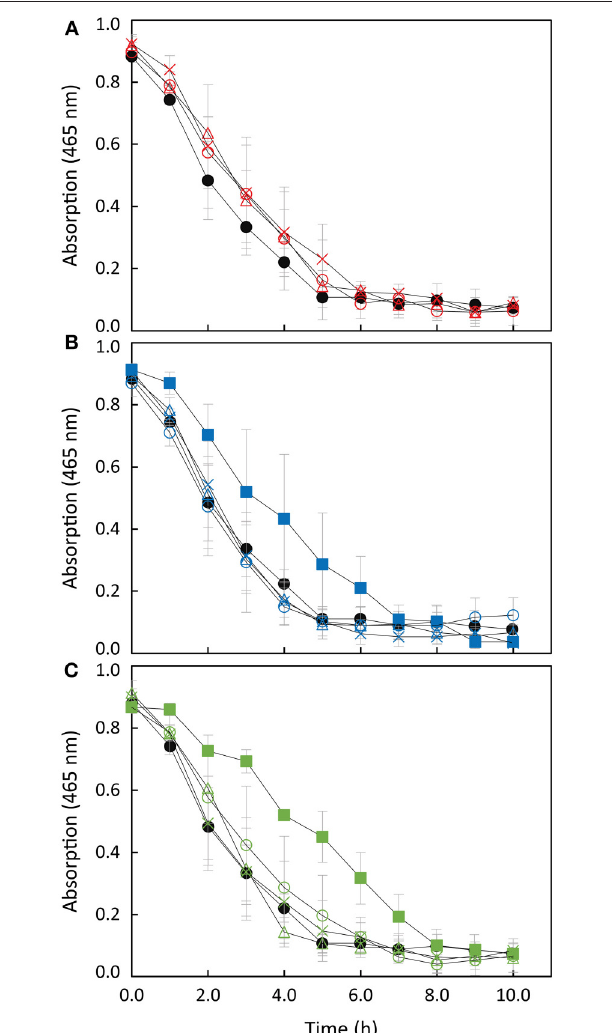
FIGURE 4 | Anaerobic reduction of MO by S. oneidensis wild-type (filled circles) and (A) strains overexpressing So STC (open triangles), Sf STC (open circles) and Sa STC (crosses); (B) S. oneidensis 1 STC (filled squares) and complemented strains [ 1 STC with So STC (open triangles), Sf STC (open circles) and Sa STC (crosses)]; (C) S. oneidensis 1 STC 1 FccA (filled squares) and complemented strains [ 1 STC 1 FccA with So STC (open triangles) and Sf STC (open circles) and Sa STC (crosses)]. The error bars represent standard deviations (SD) of the